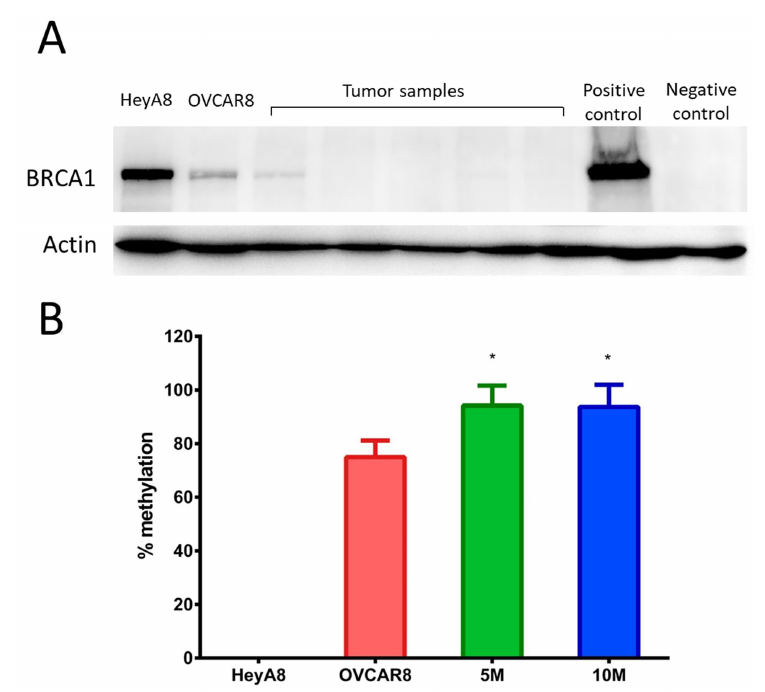
Figure 5 Figure 5. BRCA1 ( A ) expression and ( B ) methylation in BRCA1 proficient HEYA8 cells and BRCA1 deficient OVCAR8 luc cells and xenografts. BRCA1 expression as measured by western blot analysis. The extent of BRCA1 promoter methylation was examined by methylation-specific PCR in HEYA8 and OVCAR8 cells compared to tissue lysate obtained from tumor samples in mice inoculated with 5 or 10 million OVCAR8 luc cells. Data are shown as mean ± SD from three independent experiments. Statistical analysis was done by one-way ANOVA with Bonferroni’s test, * p < 0.05, compared to